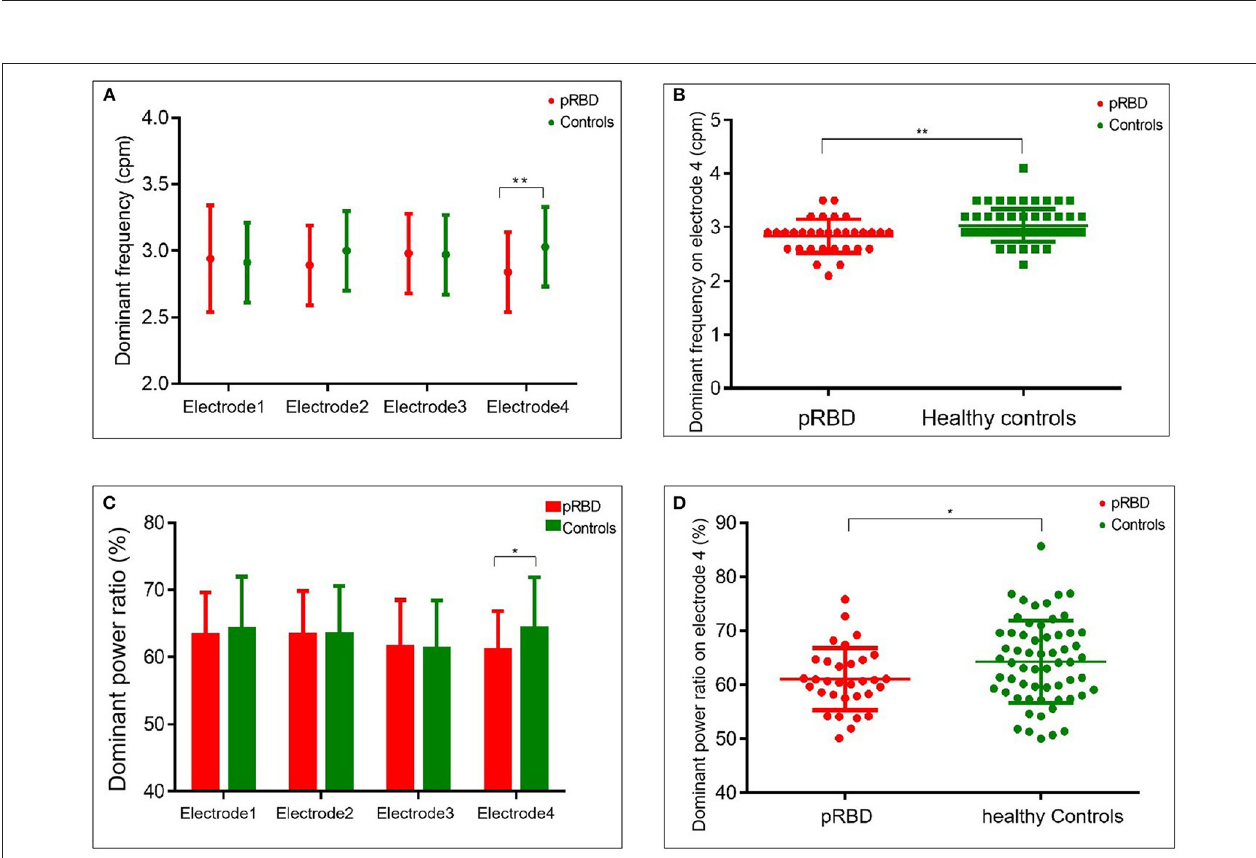
FIGURE 3 | Comparison of dominant frequency and dominant power ratio between probable REM behavior disorder (pRBD) and healthy controls. The dominant frequency was lower in pRBD than that of controls on electrode four (A,B) . A reduced dominant power ratio from the same electrode was also found on electrode four, overlying the gastric pyloric antrum (C,D) . * P < 0.05; ** P < 0.01.